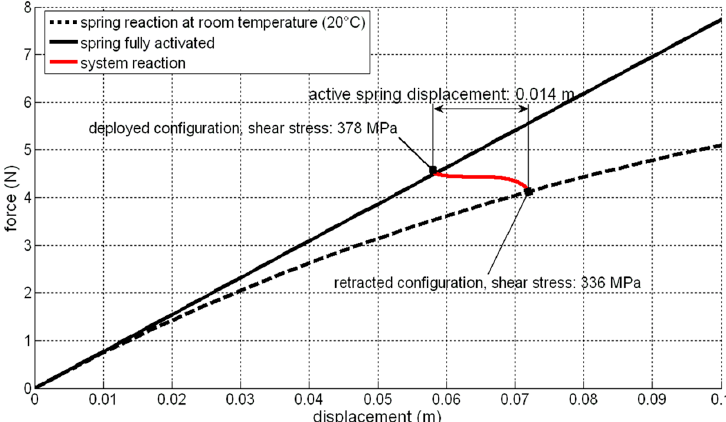
Figure 5. Force-displacement curves for the springs of the deployment subsystem: room temperature (black dashed line), full austenite (black solid line); landing gear system reaction (red line). These springs are in martensite phase at room temperature, without applied load (see transformation temperatures reported in Table 2).